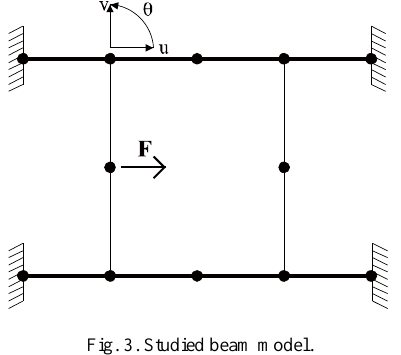
Fig. 3. Studied beam